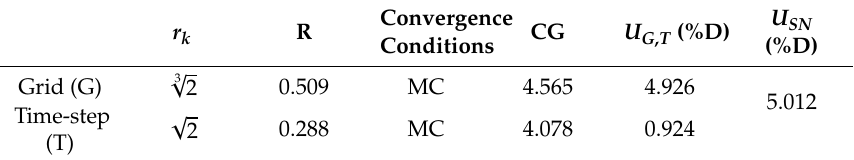
Table 10. The numerical uncertainties of the total resistance coe ffi cients of the full-scale KCS. r k R